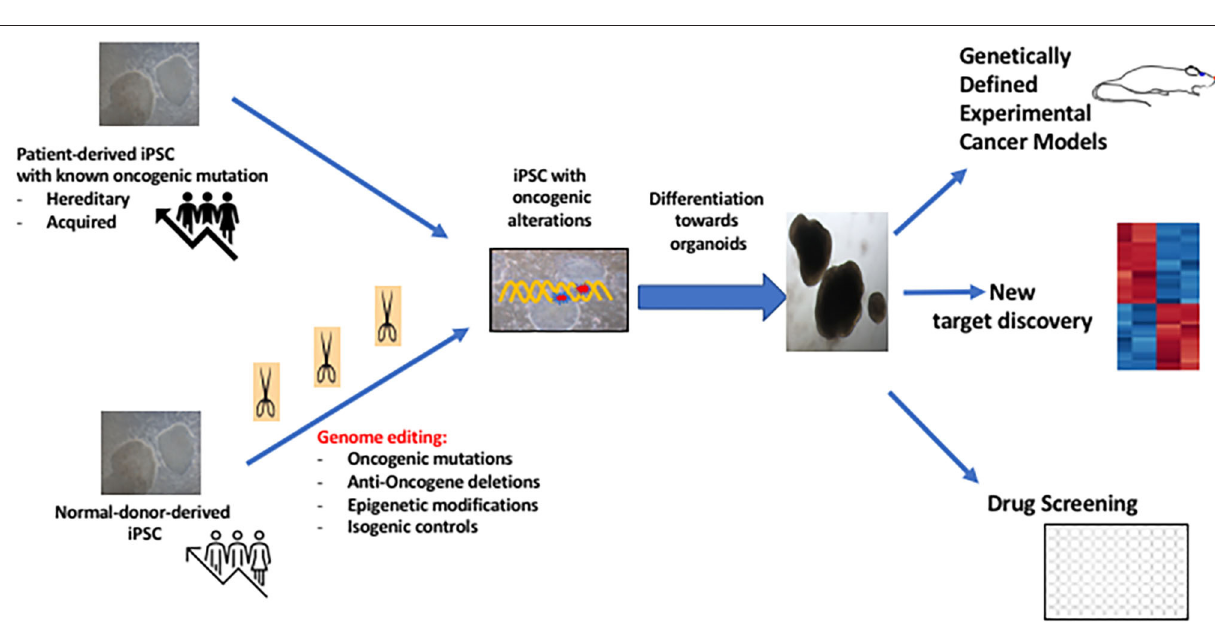
FIGURE 2 | Potential interests of iPSC-derived cancer organoids in Cancer